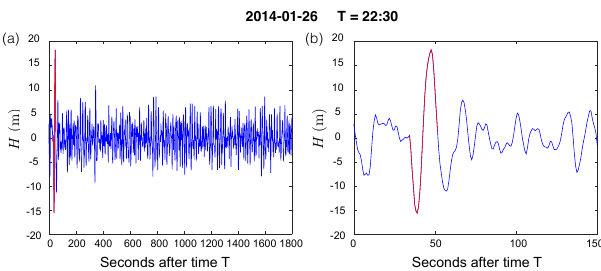
Figure 13. Wave of 33 . 96m recorded at Killard ESB buoy on 26 January 2014 (a) between 22:30 and 23:00 and (b) zoomed in. The wave as identified by its crest-to-trough is highlighted in